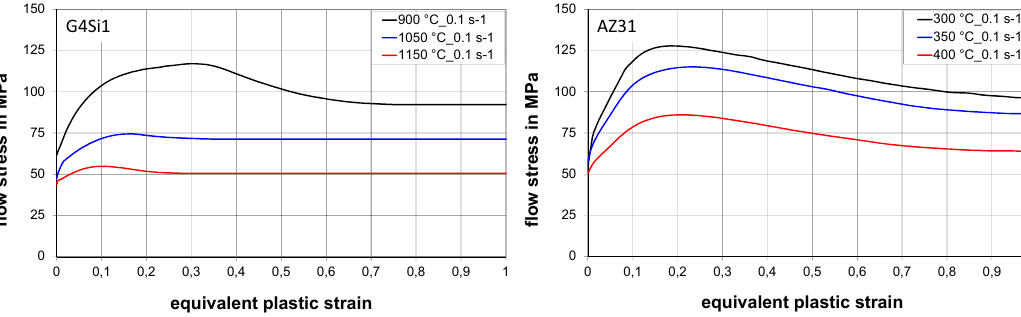
Figure 3. Flow curves as function of temperature for constant strain rate of 0.1 s ‒ 1 (( left ) G4Si1; ( right ) AZ31).